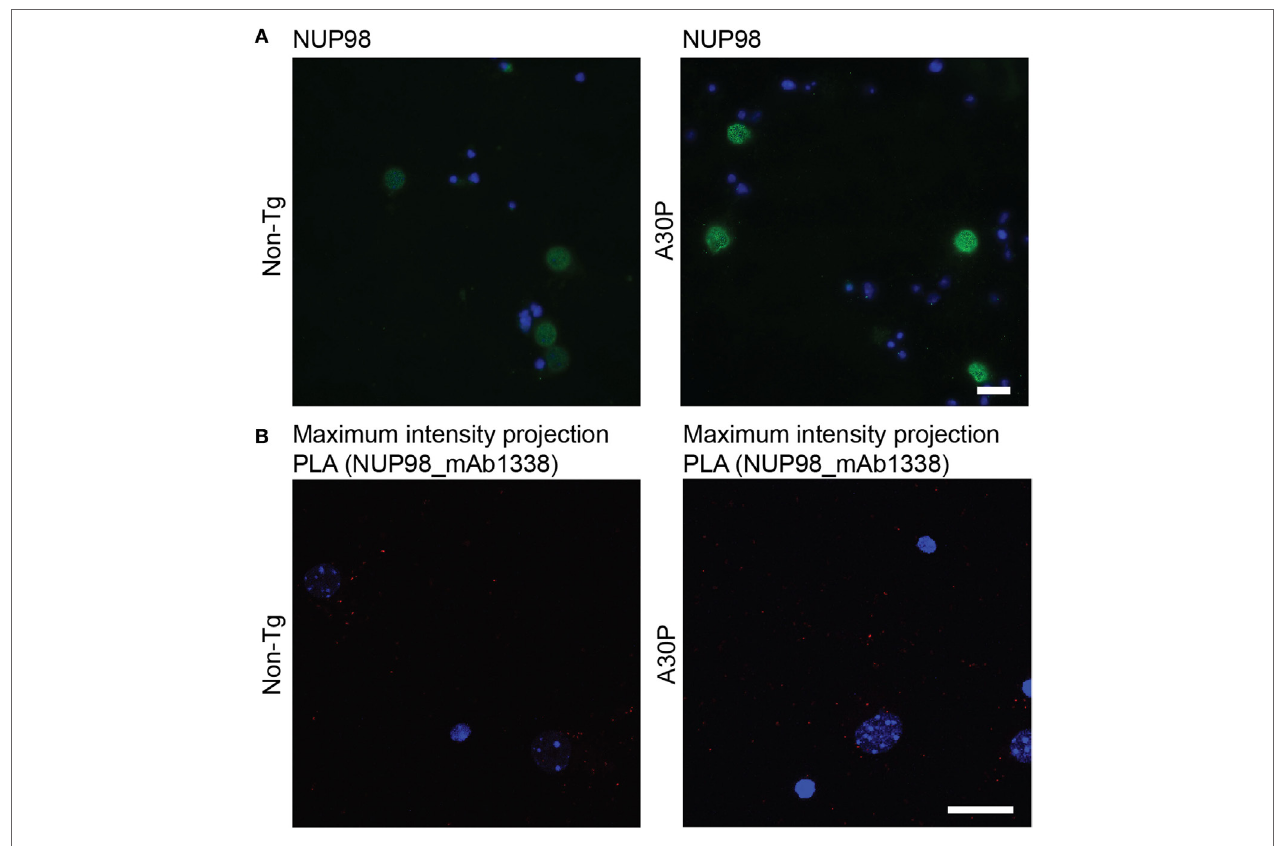
FigUre 7 | Representative images of NUP98 immunofluorescence staining (green) in non-tg and A30P alpha-synuclein ( α Syn) tg primary neurons, DAPI (blue) (a) . Representative confocal images (maximum intensity projection) of in situ proximity ligation assay (PLA) in non-tg and A30P cortical primary neurons between α Syn (mAb1338) and the NUP98 (red), DAPI (blue) (B) . Scale bar 20